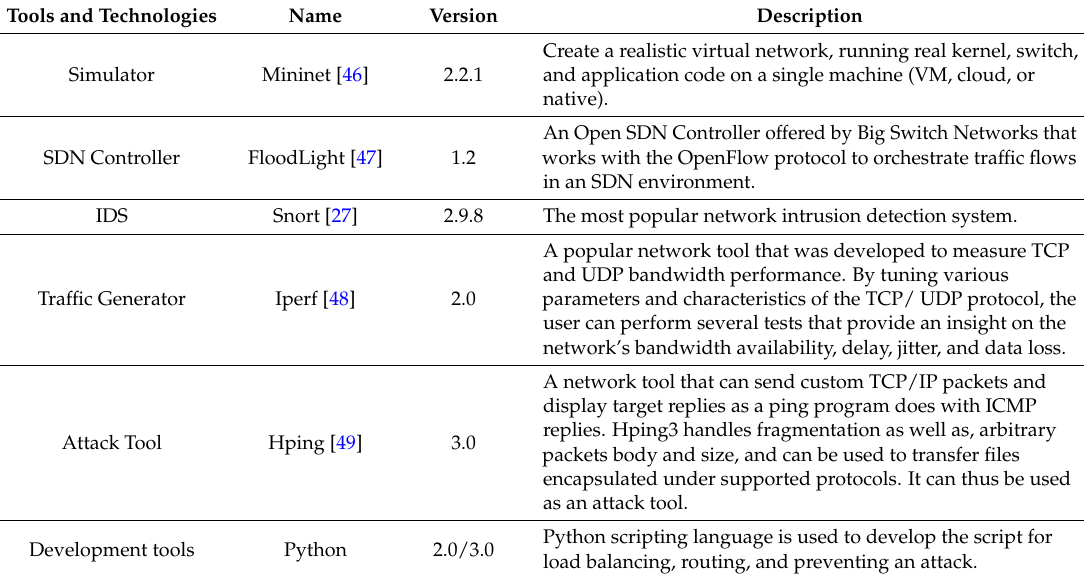
Table 2. Tools and technologies.